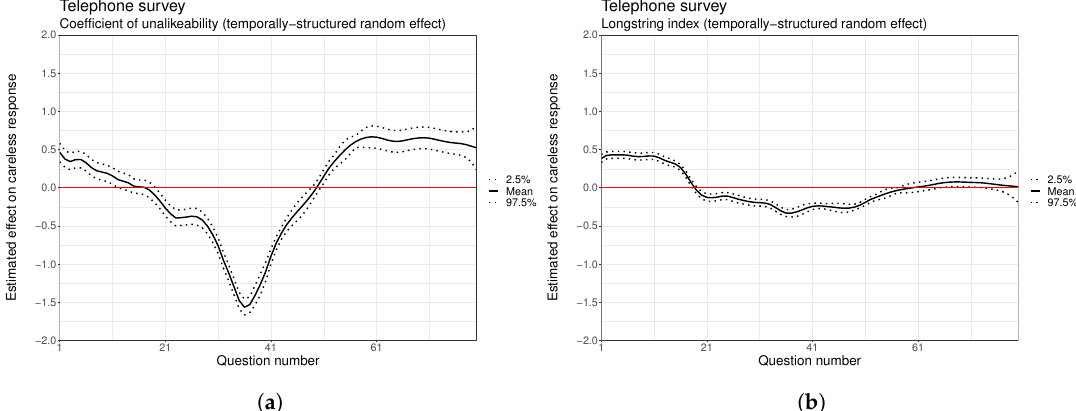
Figure 6. Estimation of the structured temporal random effect included for modeling careless response rates in the telephone survey by considering the coefficient of unalikeability ( a ) and the longstring index ( b ). These estimates correspond to ˆ γ j according to Equation (4) ( a ) and Equation 5 ( b